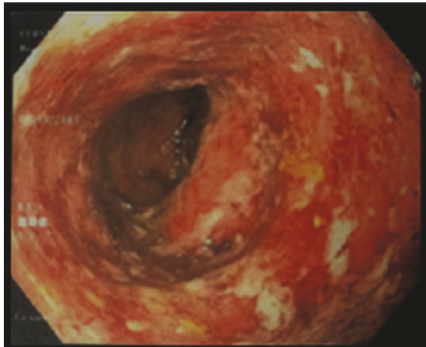
Figure 2: Sigmoid colon at colonoscopy. Inflammation character- ized by adherent blood, congestion (edema), erosions, erythema, friability, granularity, and mucus was found in a continuous and circumferential pattern.